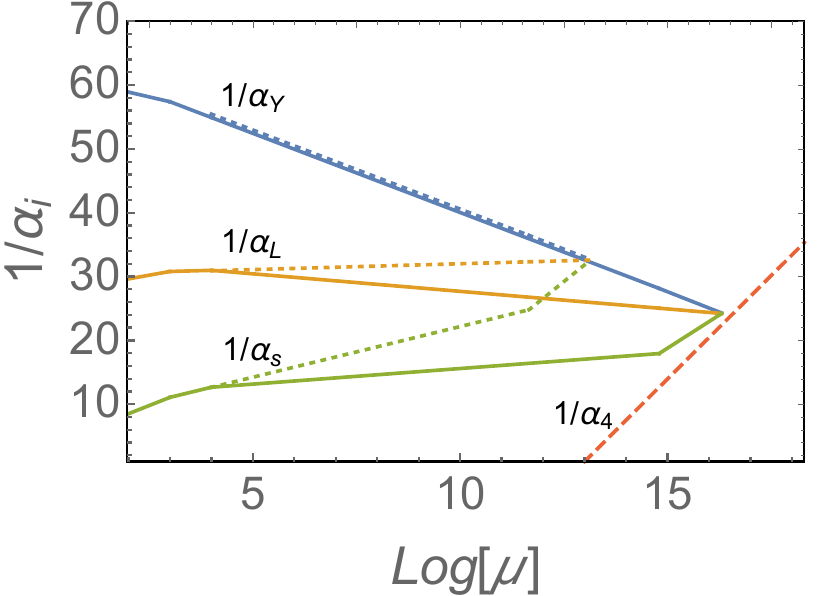
Figure 2 . Renormalization group runnings of the gauge couplings with (solid lines) and without (dotted lines) adjoint (cid:12)elds (cid:9) L;i and (cid:9) c;i at 10 TeV. The renormalization scale (cid:22) is in units of GeV. The dashed line represents the running of (cid:11) (cid:0) 1 . At the energy scale between E 4 plot (cid:11) (cid:0) 1 = (cid:11) (cid:0) 1 + (cid:11) (cid:0) 1 as an e(cid:11)ective coupling that should match the SU(3) c at E s SU(3) d SU(3) 3